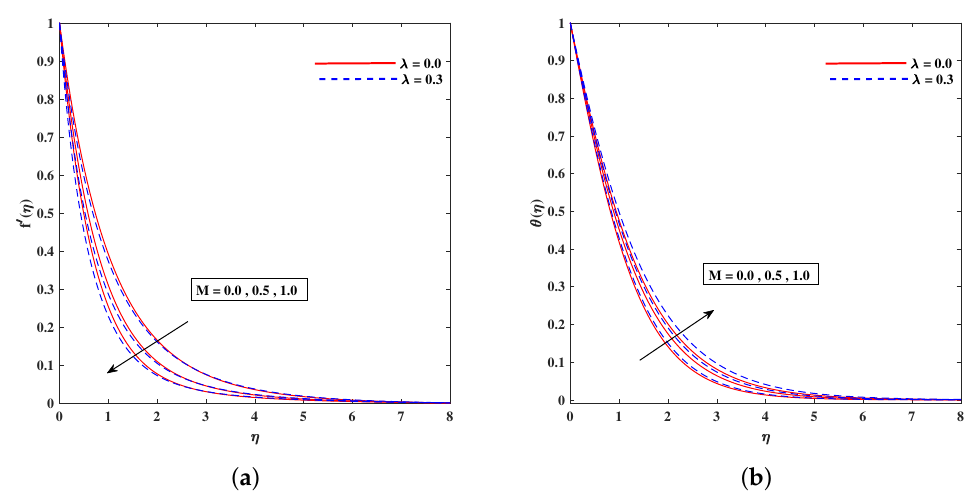
Figure 2. Fluctuation of M on velocity f (cid:48) ( η ) ( a ) and temperature profile θ ( η ) ( b ).